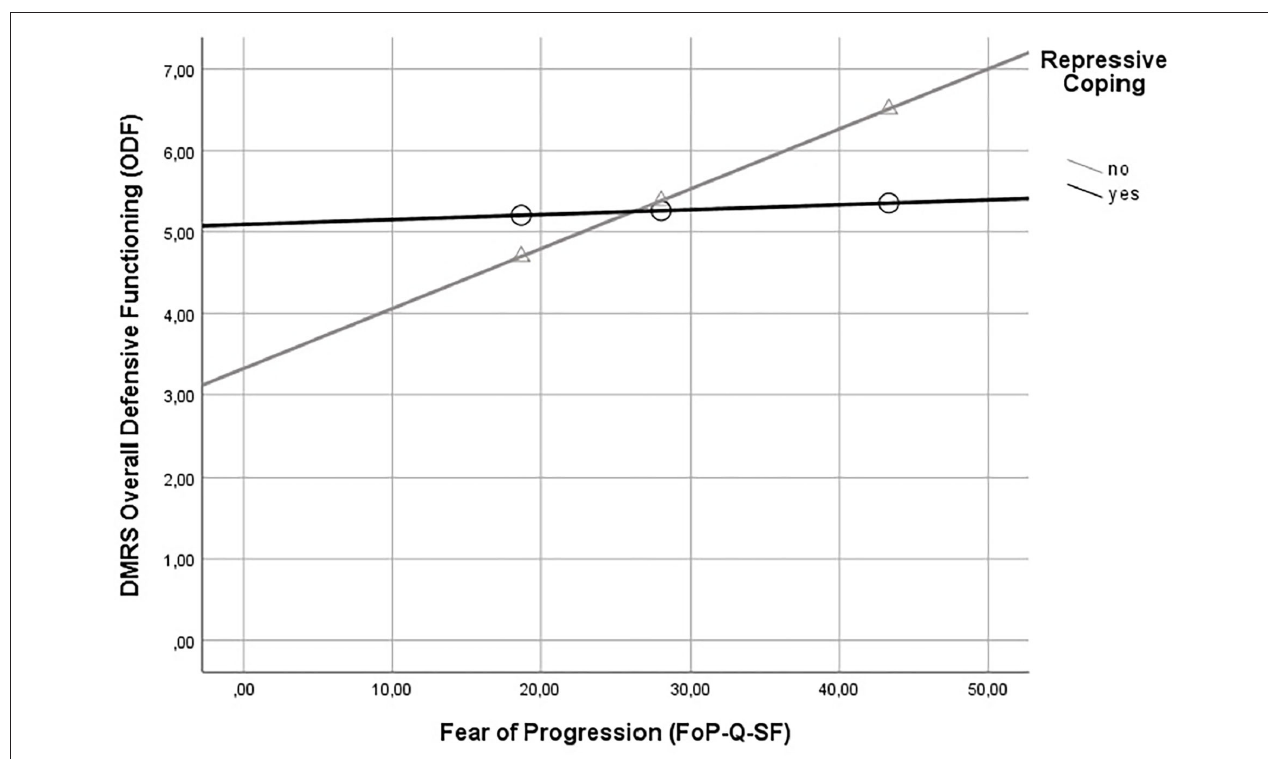
FIGURE 2 | Moderation of the association between fear of progression and defensive functioning (DMRS) by repressive coping. DMRS, Defense Mechanism Rating Scales; FoP-Q-SF, Fear of Progression; repressive coping = category derived from Marlowe-Crown Social Desirability Scale and State-Trait-Anxiety Scale (STAI-Trait). DMRS overall defensive functioning (ODF) served as the dependent